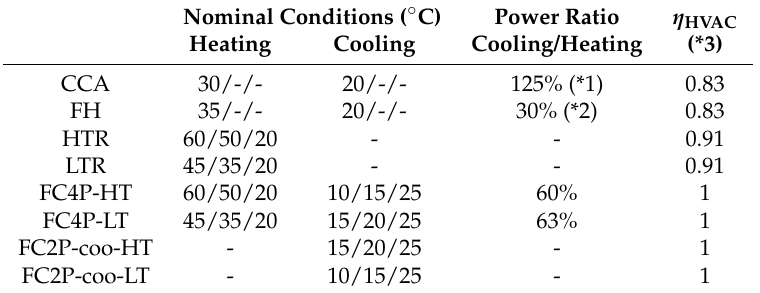
FC2P-coo-HT - FC2P-coo-LT -